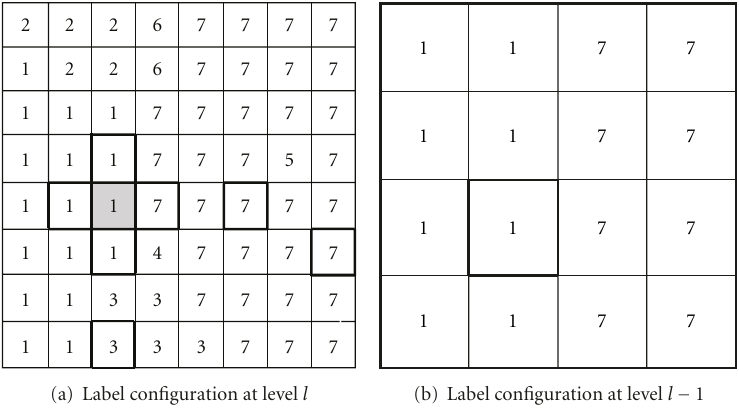
Figure 2: Voting pool of site (5, 3, l ), the grey block in (a), at resolution level l . The voting pool consists of the sites highlighted with bold line segments in both (a) and (b), which includes parent site (3, 2, l − 1) at level l − 1 in (b), 4 neighbours at (4, 3, l ), (5, 4, l ), (6, 3, l ), (5, 2, l ), two randomly picked sites at (8, 3, l ) and (6, 8, l ), and the most di ff erent site at (5, 6, l